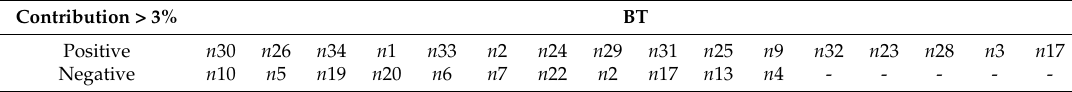
Table 4. The selected band transform bands (BTs) contain specific spectral properties (negative and positive contribution percent >